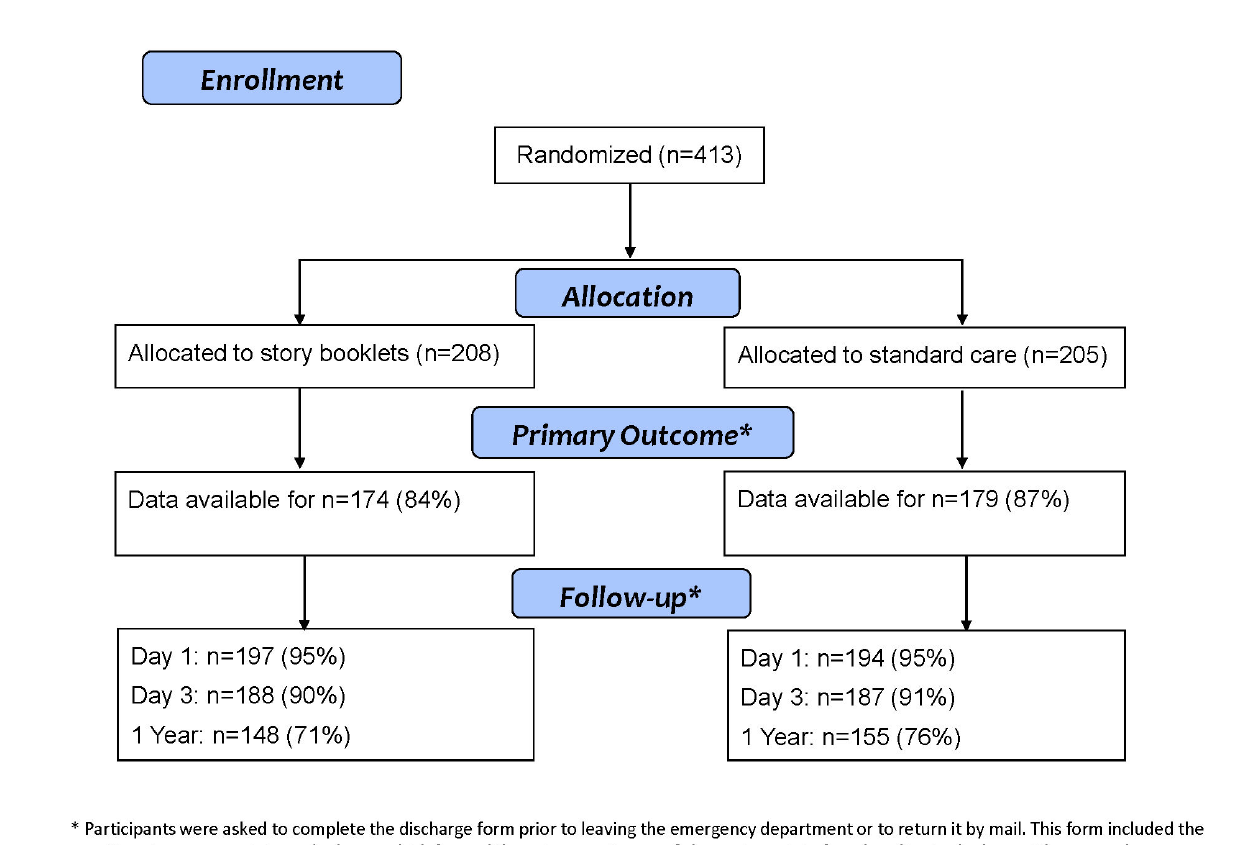
Figure 2. Recruitment and follow-up of study